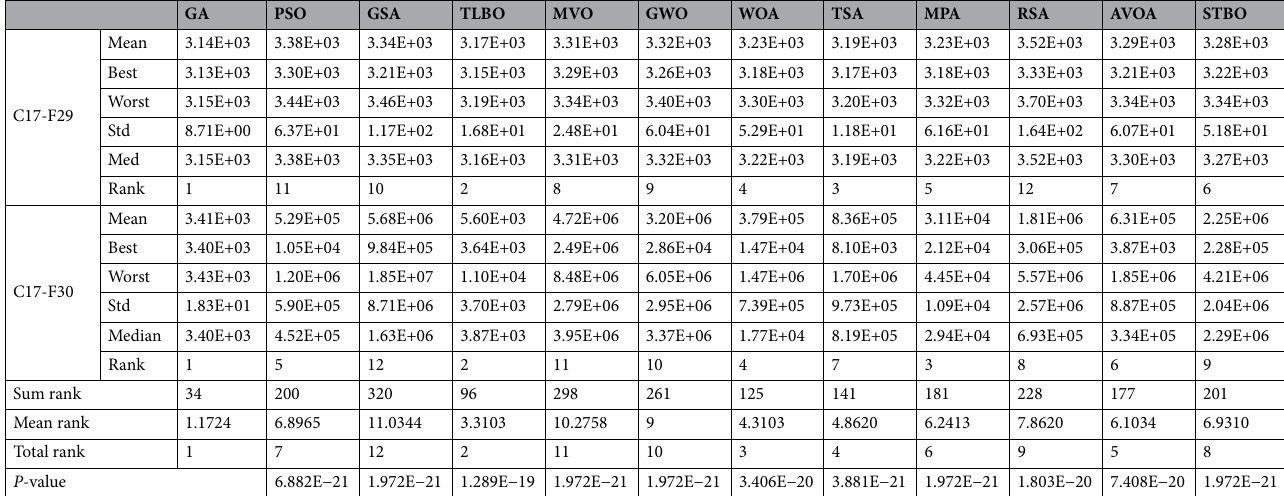
Table 8. Evaluation results on the CEC 2017 test suite functions.